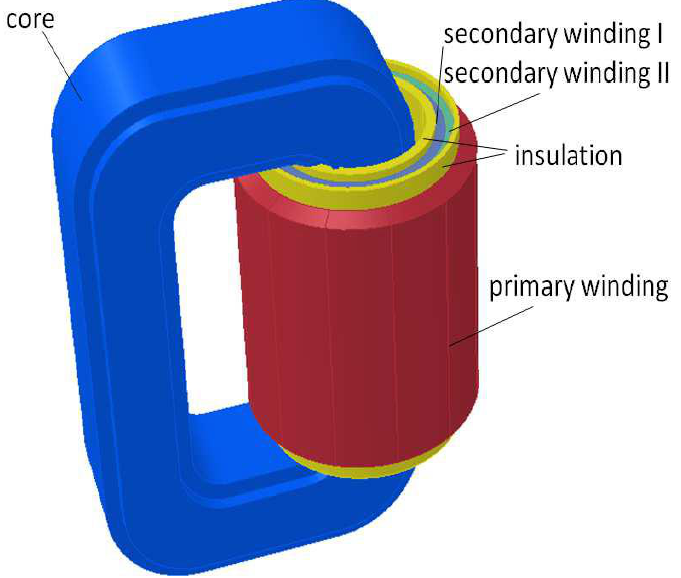
Figure 1. 3D geometrical model of the measuring voltage transformer 2000 V/100 V.